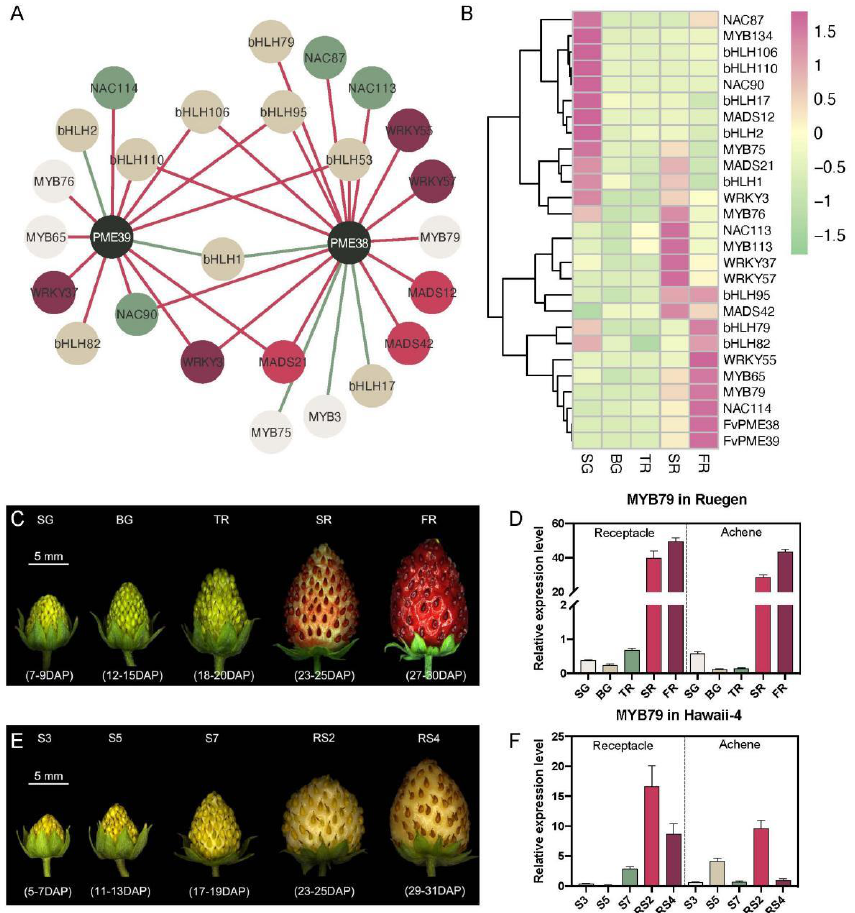
Figure 2. Co-expression network and expression profile of FvMYB79 . ( A ) Co-expression network analysis of FvPME38 , FvPME39 and a series of transcription factor genes. Green line, negative correlation; red line, positive correlation. P -values were determined by two-tailed Student’s t -test assuming equal variances. ( B ) Relative transcription levels of candidate transcription factor genes were detected during ‘Ruegen’ fruit development by q-PCR. The data of each gene were centred and scaled in different stages via the heatmap package in R Studio Software, version 3.1.1. P -values were determined by two-tailed Student’s t-test assuming equal variances. ( C , E ) Five stages of ‘Ruegen’ and ‘Hawaii 4’ fruit development, respectively. ‘Ruegen’ fruit developmental stages: small green (SG), big green (BG), turning red (TR), start red (SR), and full red (FR). ‘Hawaii 4’ fruit developmental stages: S3, S5, S7, RS2 and RS4 were described previously [12,18]. ( D , F ) Spatial and temporal expression level of FvMYB79 gene during ‘Ruegen’ and ‘Hawaii 4’ fruit development in achenes and receptacles. Error bars represent SD of three independent